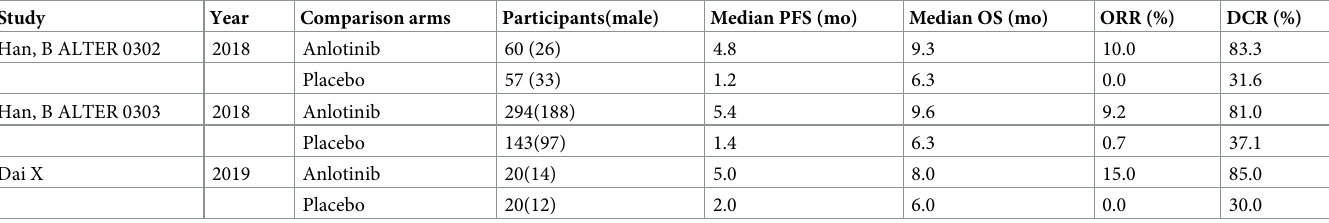
Table 1. The characteristics such as comparison arms, median PFS, median OS, ORR, and DCR of the included studies. Study